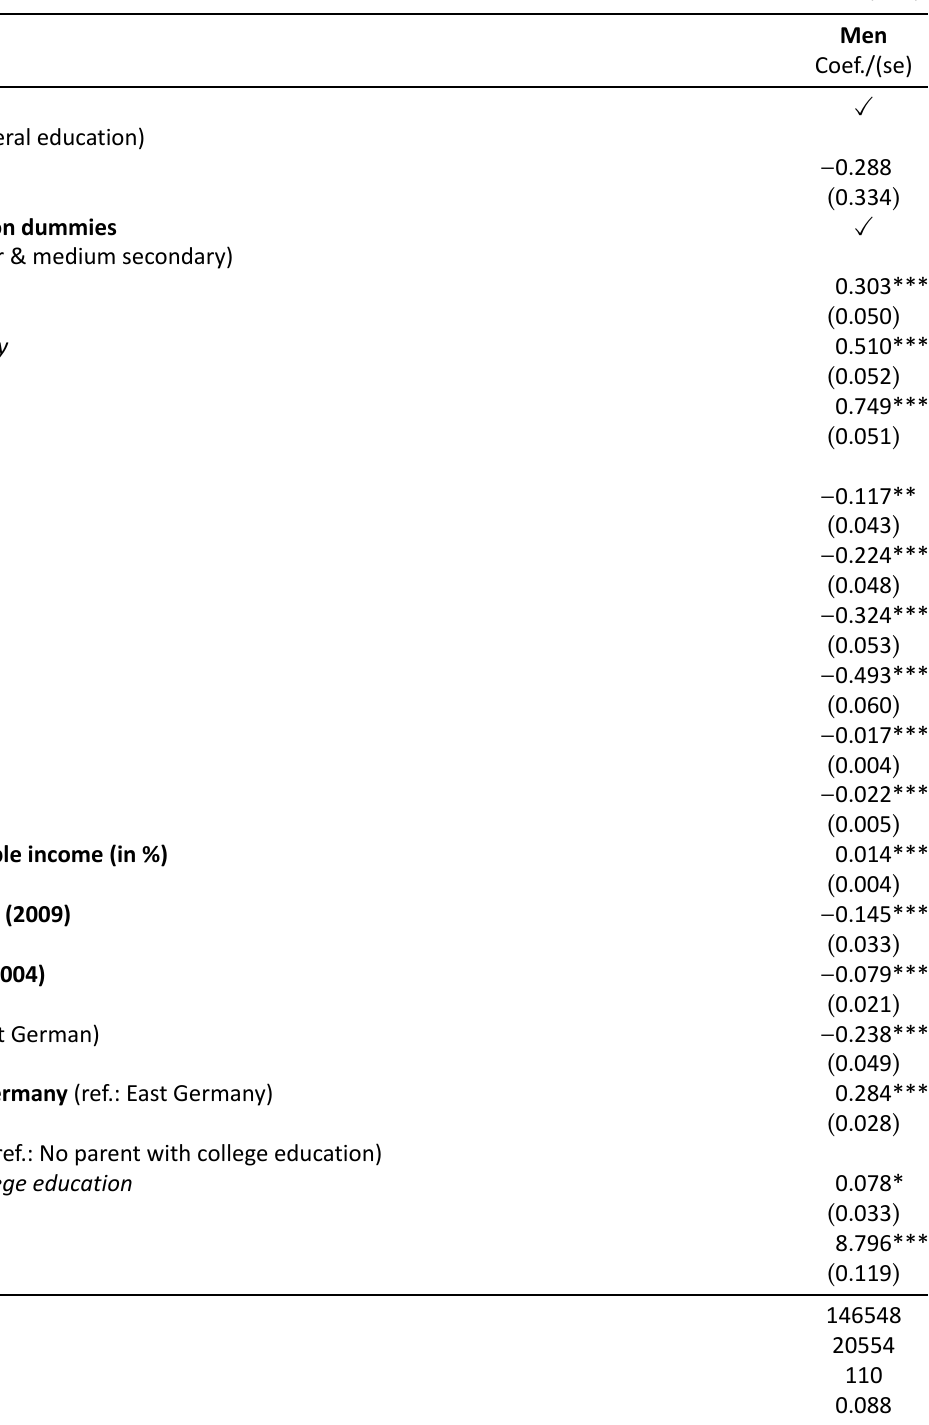
Table A9. Health satisfaction over the life course: General versus vocational education for men. Data source: GSOEP (n.d.).